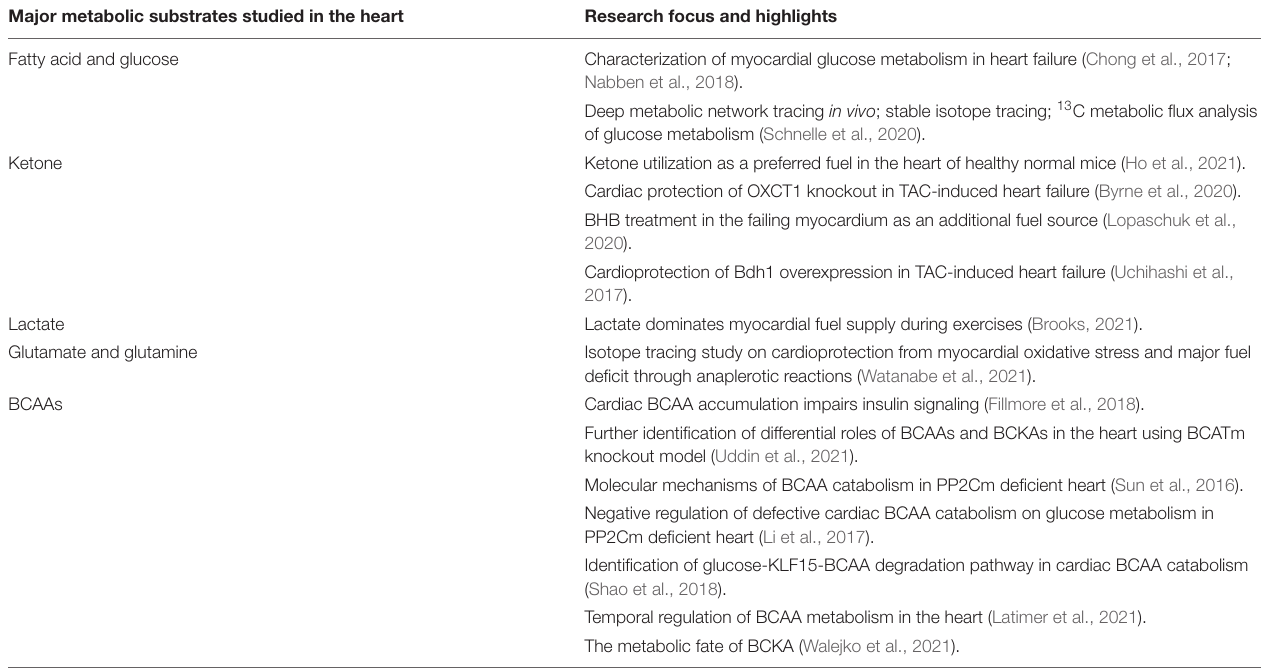
TABLE 1 | Summarization of recent studies on myocardial substrate utilization involved in cardiac pathophysiology. Major metabolic substrates studied in the